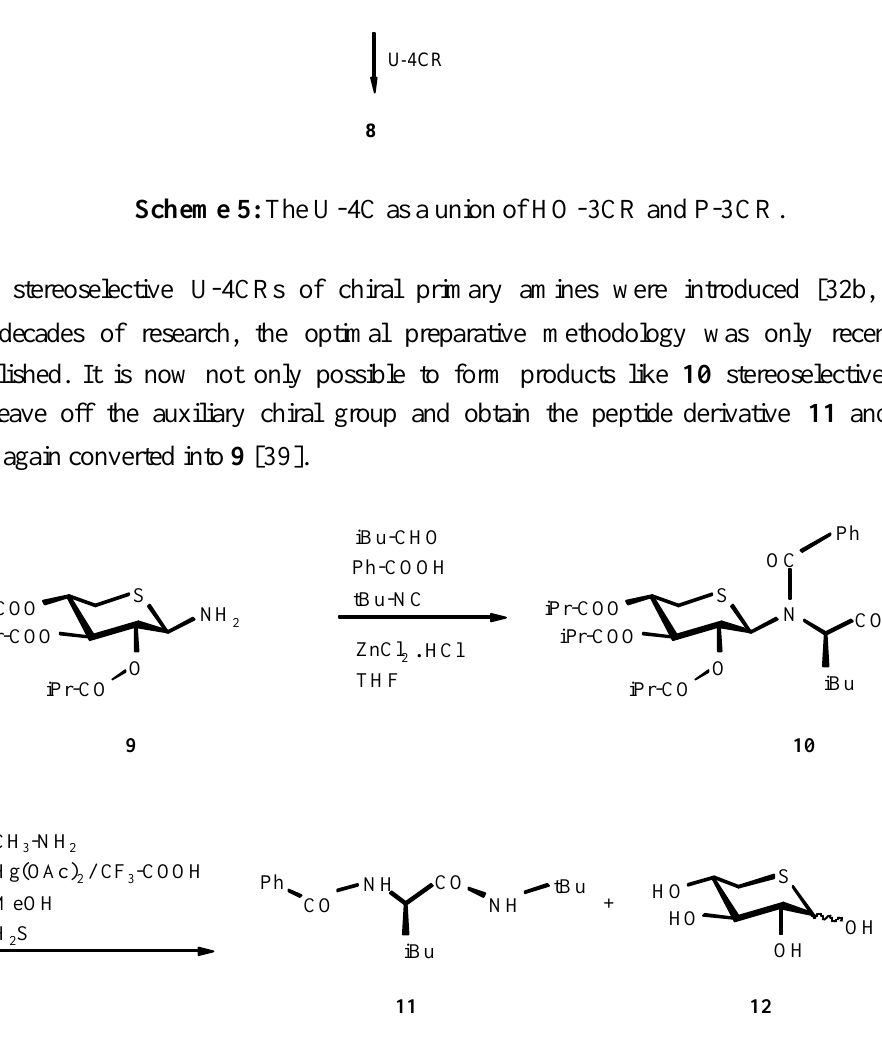
Scheme 6: Stereoselective synthesis of aminoacid derivatives via